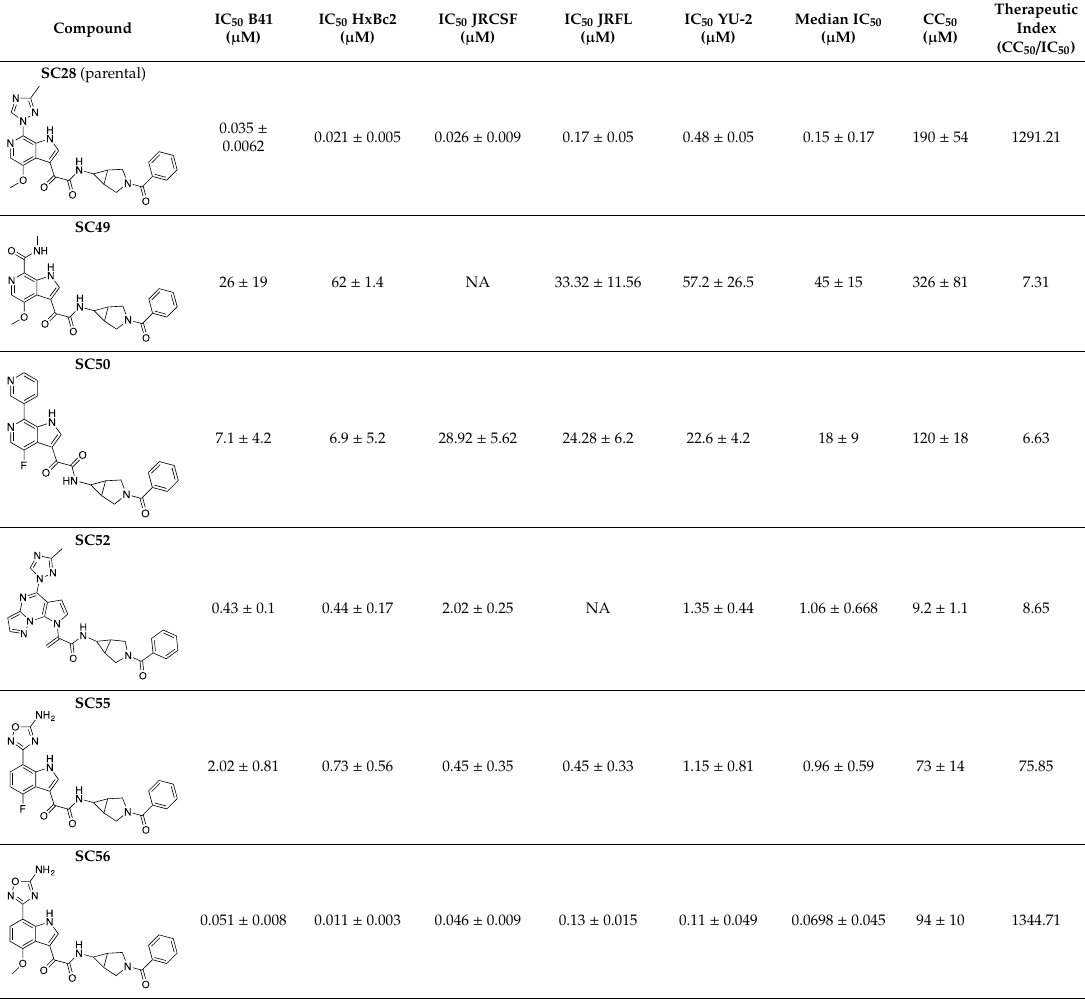
Table 4. Potency and toxicity of compounds against HIV-1 B41 , HIV-1 HxBc2 , HIV-1 JRCSF, HIV-1 JRFL, and HIV-1 YU-2 Env pseudotyped HIV-1. The chemical structures were drawn with ChemAxon software (Budapest, Hungary).